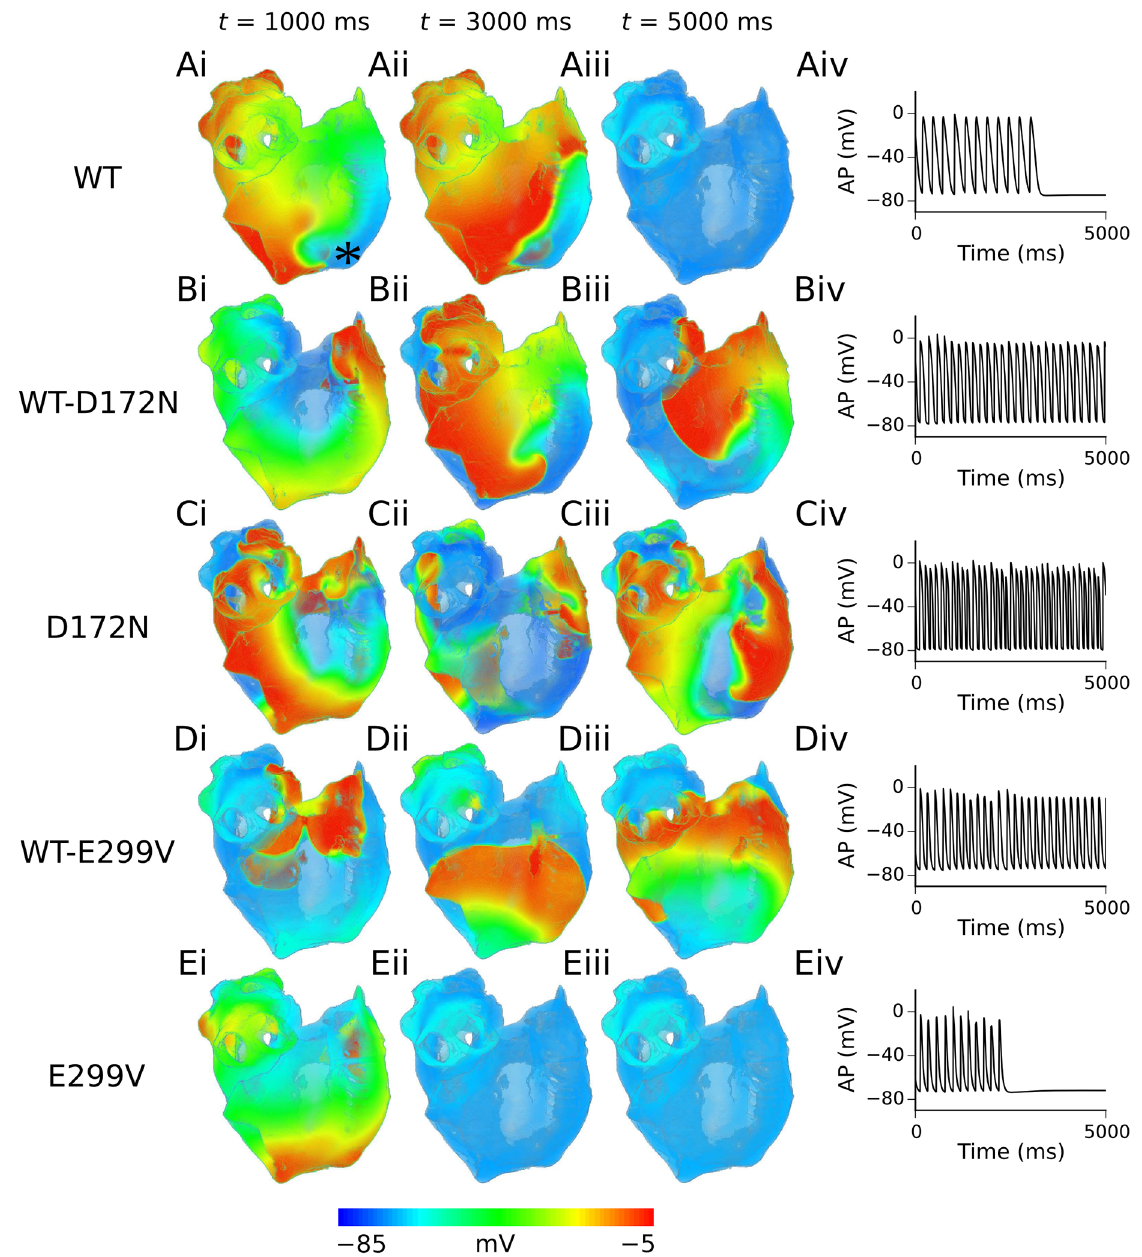
Fig 6. Scroll waves and corresponding APs in 3D virtual human atria. Evolution of scroll waves followinginitiationof re-entry, from time t = 1000 ms (i) to t = 3000 ms (ii) to t = 5000 ms (iii) in WT (A), WT-D172N (B), D172N (C), WT-E299V (D), and E299V (E) conditions, with corresponding APs extracted from the RA (recordinglocationis marked with an asterisk in panel Ai) (iv). The viewpointis lookingat the RA posterior wall.